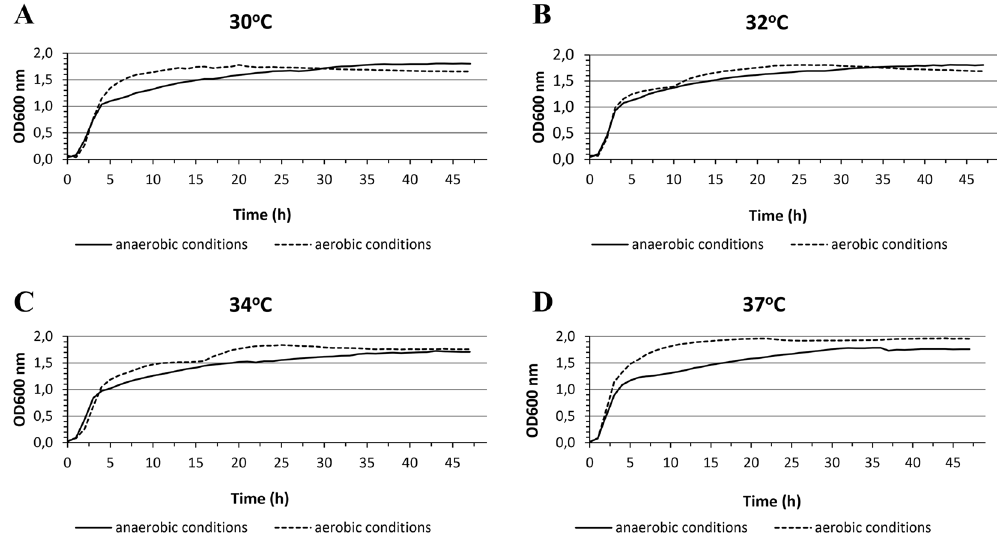
Figure 5. Growth of Enterobacter aerogenes LU2 under anaerobic and aerobic conditions at temperature of 30 o C ( A ), 32 o C ( B ), 34 o C ( C ) and 37 o C ( D ). The OD600 nm was measured every 1 h for 48 h. All samples were analyzed in three full biological